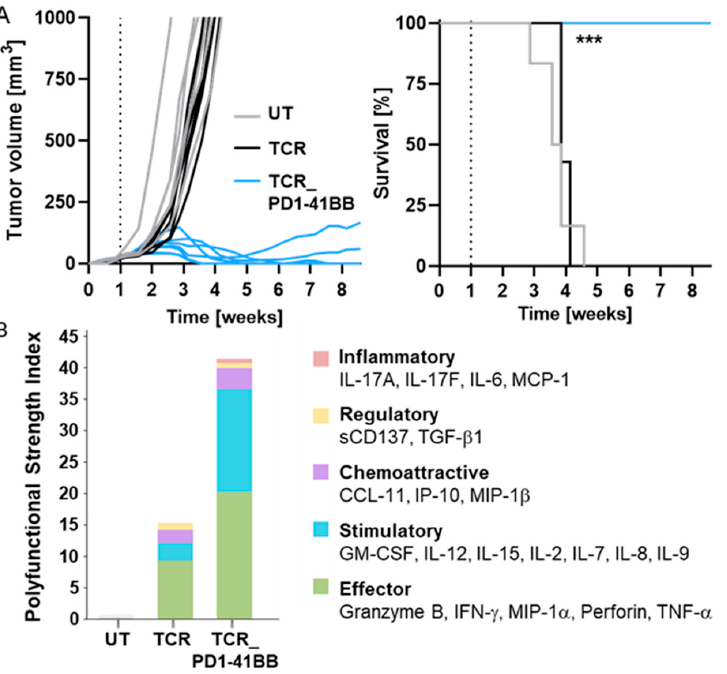
Figure 4. TCR-Ts co-expressing PD1-41BB reject tumor cells in vivo and show a superior poly- cytokine profile. ( A ) 5 × 10 6 MelA375_PD-L1 cells were injected s.c. into immunodeficient (NOD/Shi- scid/IL-2R γ null) mice. Mice were treated on day seven either with 10 × 10 6 PRAME-TCR-positive